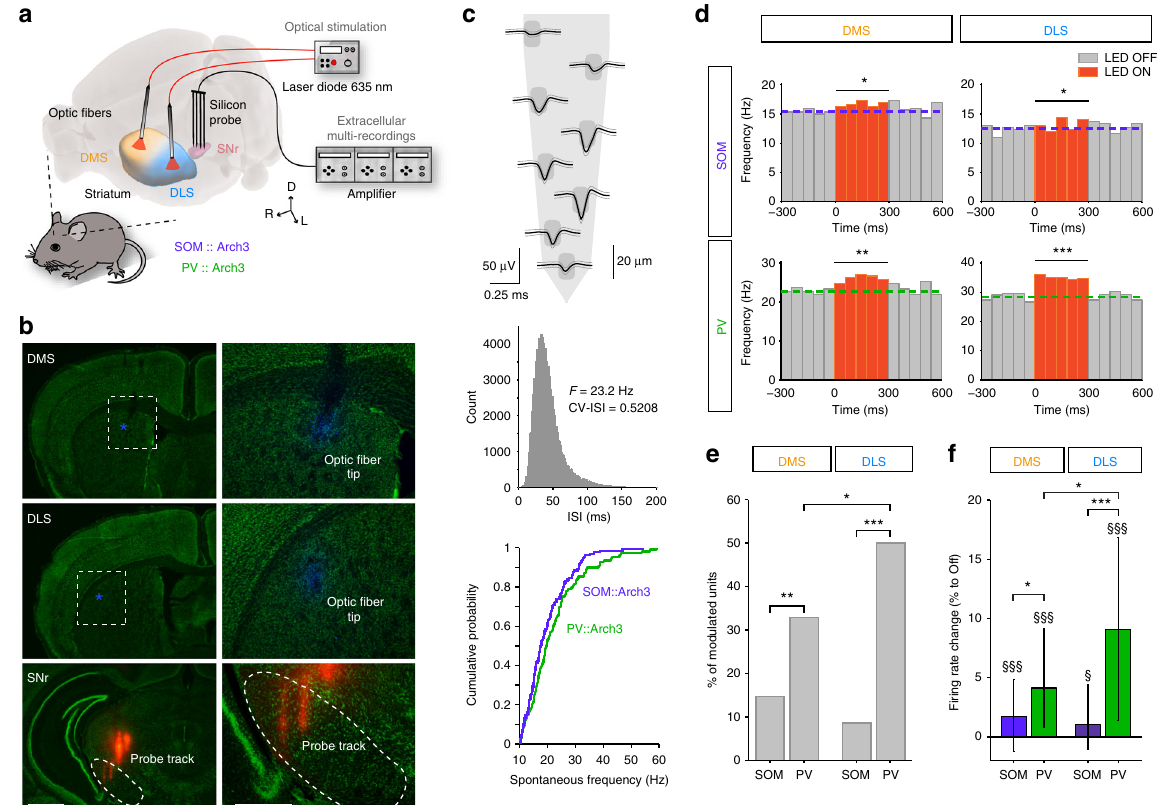
Fig. 1 Differential modulation of basal ganglia output activity by SOM and PV cells of DMS and DLS. a Experimental set up: in vivo multi-channel extracellular recordings of SNr unit activity using 4-shank 32-site silicon probe while PV or SOM interneurons are opto-inhibited using two optic fi bers implanted in the DMS and DLS. b Post-hoc histological con fi rmation of the location of the recording probe (shanks painted with DiI before the implantation, red) in the SNr (delineated) and the two optic fi bers (tips painted with DAPI, blue) in DMS and DLS, observed in Nissl-stained (green) coronal slices. Scale bars: 1 mm (left), 500 µ m (right). c Top: Mean ± SD (black and gray lines) waveform of a clustered SNr unit represented atop the corresponding recording sites of the probe (sketch of 1 shank, the 8 recording sites in dark gray). Middle: Distribution of the interspike interval (ISI) of the same unit, displaying the high frequency and low CV-ISI typical of SNr units. Bottom: the distribution of SNr spontaneous fi ring rates is similar in SOM::Arch3 mice ( n = 130 units from 17 mice) and PV::Arch3 mice ( n = 109 units from 13 mice) (Kolmogorov – Smirnov test, p = 0.2044). d Spontaneous fi ring activity of representative SNr units signi fi cantly activated by opto-inhibition (300 ms, 10 mW, 50 trials) of SOM (top) or PV (bottom) light in DMS (left) or DLS (right). The colored dashed lines represent the median of the 300 ms-OFF period before the stimulation. e Proportion of SNr units displaying a signi fi cant modulation of their fi ring in response to opto-inhibition of PV or SOM interneurons in DMS or DLS (total n = 109 units for SOM::Arch3 in DMS, n = 69 in DLS, n = 79 units for PV::Arch3 mice in DMS, n = 68 in DLS). f Median (IQR) change in fi ring rate of all recorded SNr units in response to opto-inhibition of PV (green) and SOM (purple) interneurons in the DMS and DLS. §§§ Indicates a signi fi cant effect across the population of recorded SNr units for PV-DLS ( $ p < 0.05, $$$ p < 0.001, Wilcoxon signed rank test corrected for multiple comparisons). In e and f , results in the 4 conditions were compared using a generalized linear ( e ) or a linear ( f ) model (see Methods) followed by post-hoc tests, * p < 0.05, ** p < 0.01, *** p < 0.001. For the 3D images in a , brain and brain structures are captured from the Allen Institute for Brain Science ’ s Mouse Brain Atlas 74 (© 2004 Allen Institute for Brain Science, Allen Mouse Brain Atlas available from: mouse.brain-map.org/) using Brain Explorer ® 2